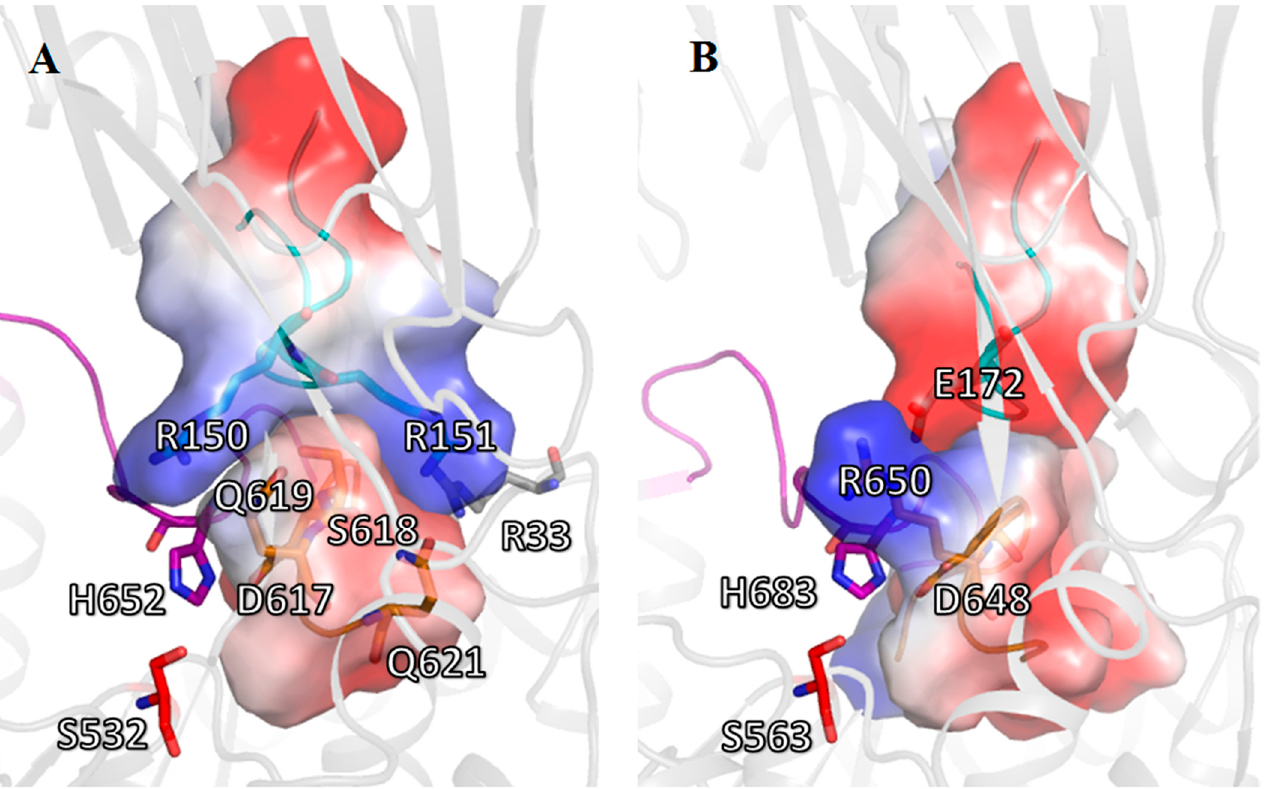
Figure 8. Cartoon/surface presentation of the electrostatic interactions between D-loops of the catalytic domains and the R151/E172-carrying loop (R/E-loop) of the β -propeller domain in the closed state of SpOpB ( A ) and TbOpB ( B ). The H-, D-, and R/E-loops are in magenta, gold, and cyan, respectively. Amino acid residues L615—Q621 (SpOpB) and A644—Y653 (TbOpB) from the D-loops, as well as D146—D154 (SpOpB) and D167—S175 (TbOpB) from the R/E-loops, are shown as surfaces colored according to their electrostatic potential. Positive and negative charges are in blue and red, respectively. The color scale is in units of kT/e ranging from − 50 to